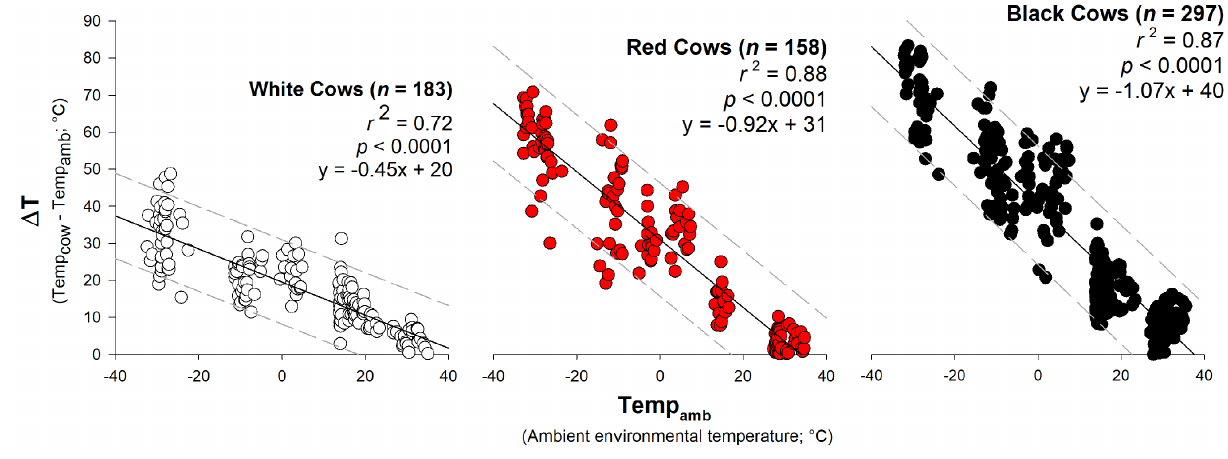
Figure 5. Linear least-squares regression to analyze how ambient environmental temperature (Temp amb ) predicts ∆ T (the